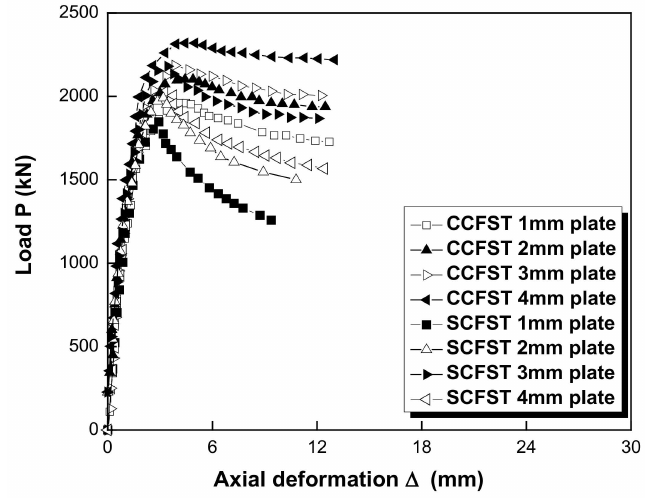
Figure 10. Axial load (P)-axial deformation ( ∆ ) of the CCFST and SCFST models with different cross-shaped plates.